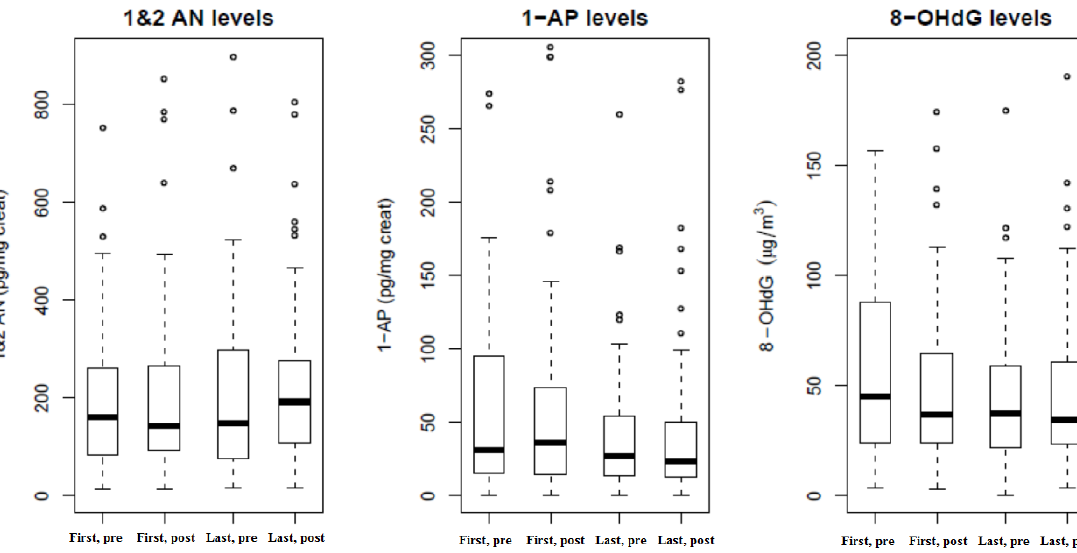
Figure 2. Boxplots for mean 1 & 2 aminonaphthalene (1 & 2-AN), 1-aminopyrene (1-AP) and 8-hydroxy-2'-deoxyguanosine (8-OHdG) levels for different measurement points (pre- and post-shift measurements on the first and last days of the